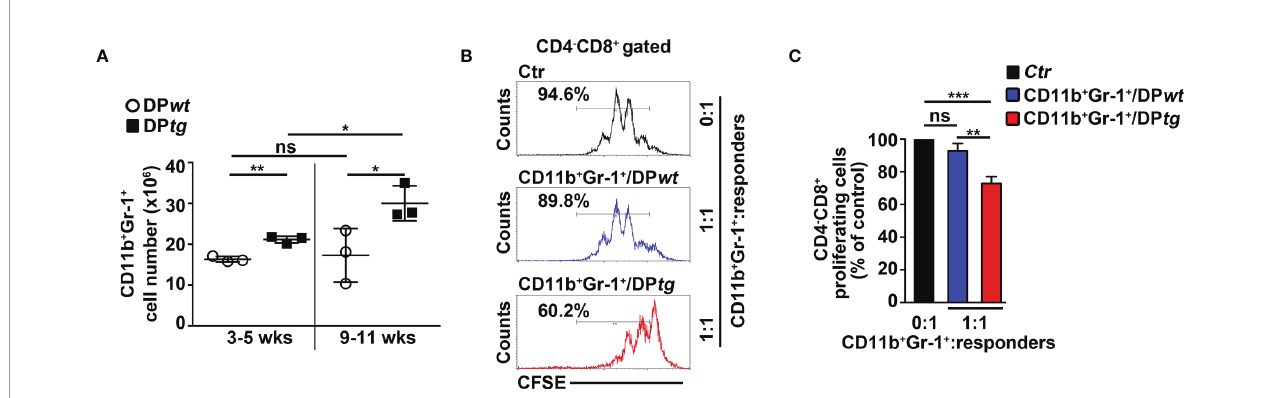
FIGURE 4 | CD4 + CD8 + (DP) T cells from N3-tg mice induce CD11b + Gr-1 + MDSCs in NSG hosts. NSG recipients were transplanted i.v. with CD4 + CD8 + (DP) T cells sorted from BM of N3-tg mice (DP tg ; n = 3 donors) or from thymus of wt mice (DP wt ; n = 3 donors), as a control. Each of the donors has two recipients. NSG recipients were sacri fi ced at 3 – 5 weeks ( n = 3 NSG recipients per group) and 9 – 11 weeks ( n = 3 NSG recipients per group) posttransplantation and analyzed by FACS. (A) Absolute numbers of CD11b + Gr-1 + cells in BM of NSG mice, recipients of DP wt or DP tg cells, assessed by FACS analysis, at 3 – 5